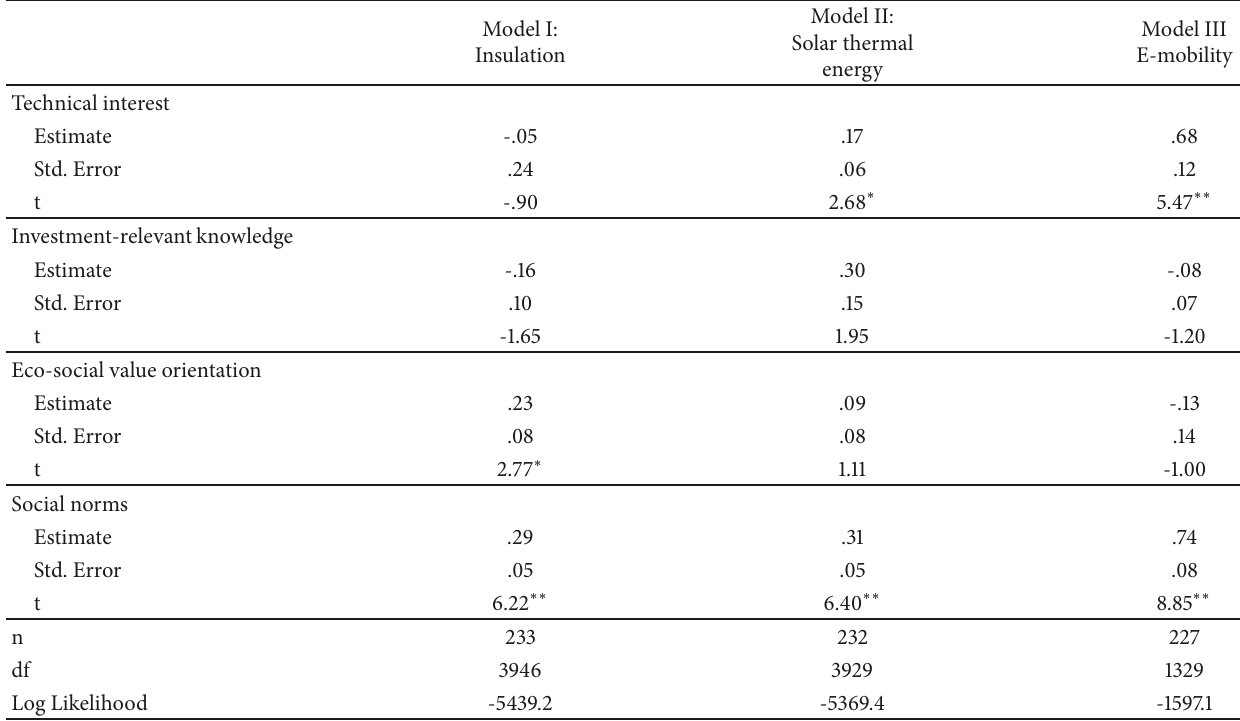
Table 3: Estimated Choice Models.